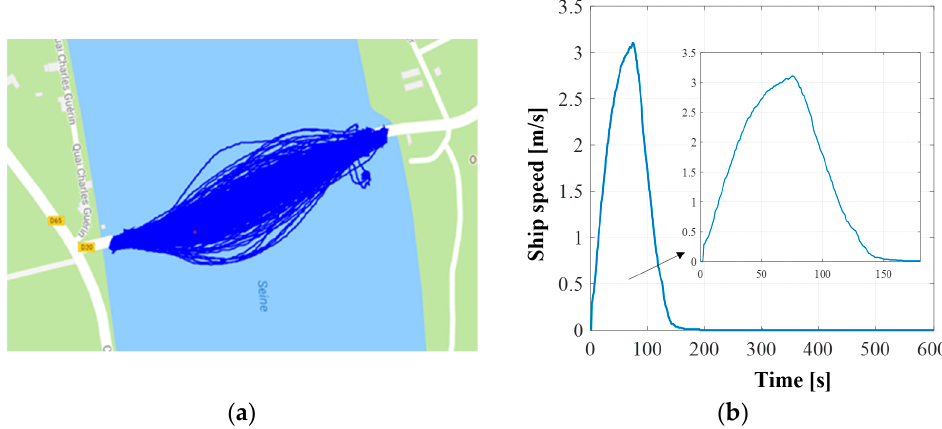
Figure 2. Recorded crossing trajectories ( a ) and mean speed profile for one river crossing ( b ).